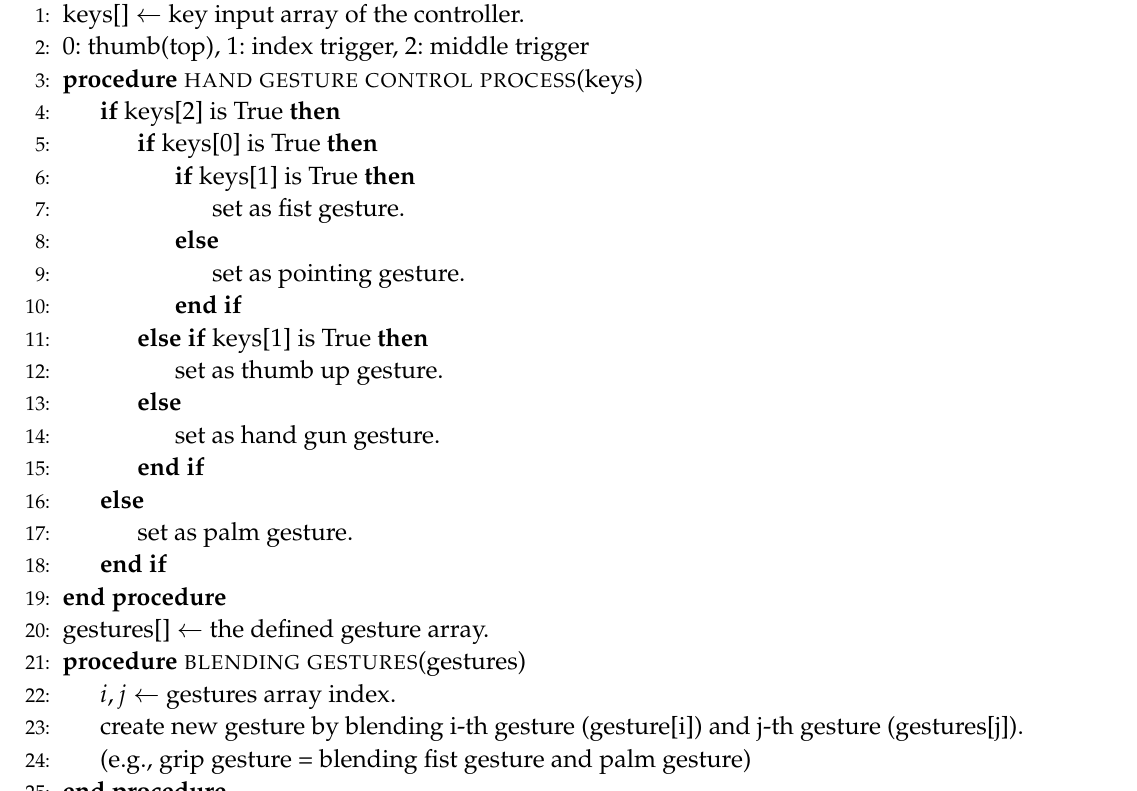
Algorithm 1 is the summary of the process of passing the gestures from the real hand to the virtual hand using a controller. In this study, hand gestures are classified into five categories, and the corresponding controller input settings are defined. Further, structures of bleding gestures (e.g., generate grip motion from fist gesture and palm gesture) that can be derived from the five gestures are configured. The structures for the gestures are constructed such that they can be deleted or added as needed. Algorithm 1 Process of real-to-virtual direct hand interface using